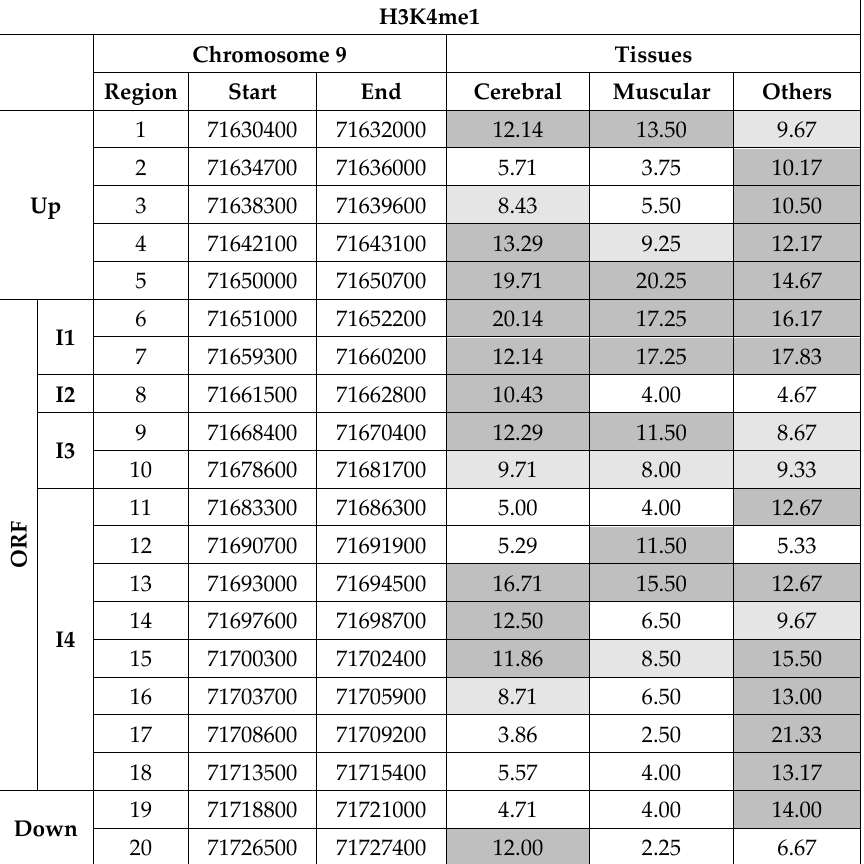
Table 2. Intensity of the H3K4me1 epigenetic mark across the studied region: “weak” (<7.5; white), “intermediate” (7.5–10; light grey) or “strong” signal (> 10; dark grey). Abbreviations: Down, Table 2. IntensityoftheH3K4me1epigeneticmarkacrossthestudiedregion: “weak”( < 7.5;white),“intermediate” Downstream region; Ix, Intron x; ORF, Open Reading Frame; Up, Upstream (7.5–10; light grey) or “strong” signal ( > 10; dark grey). Abbreviations: Down, Downstream region; Ix, Intron x; ORF, Open Reading Frame; Up, Upstream region.